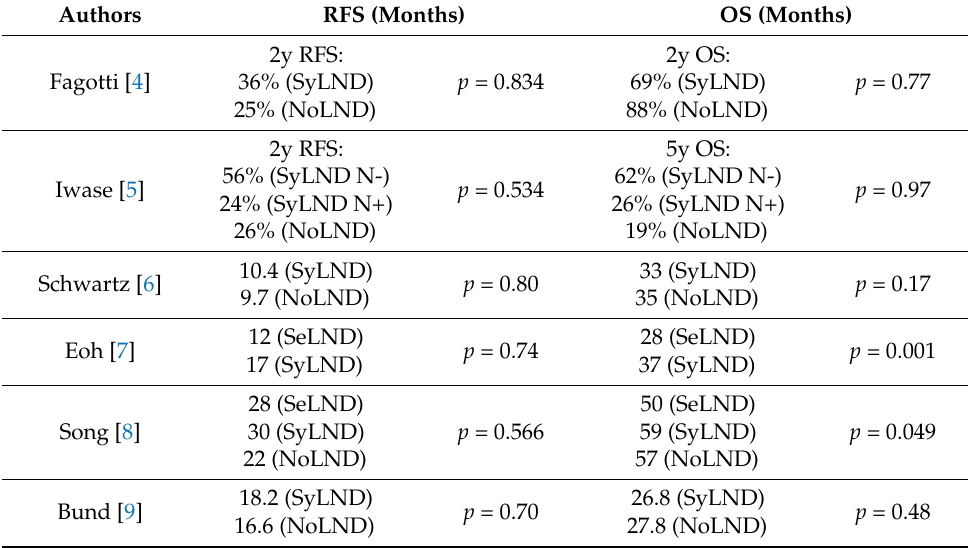
Table 3. Oncological